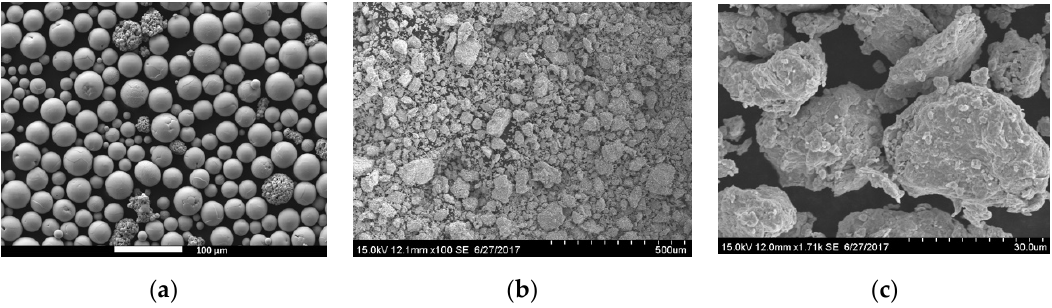
Figure 15. SEM microstructural analysis of commercial Mo-45 powders ( a ) and mechanically activated molybdenum powder agglomerates ( b , c ); ( b ) overview of the agglomerates showing that they can reach a size greater than 50 μm, and ( c ) observation of mechanically activated agglomerates.